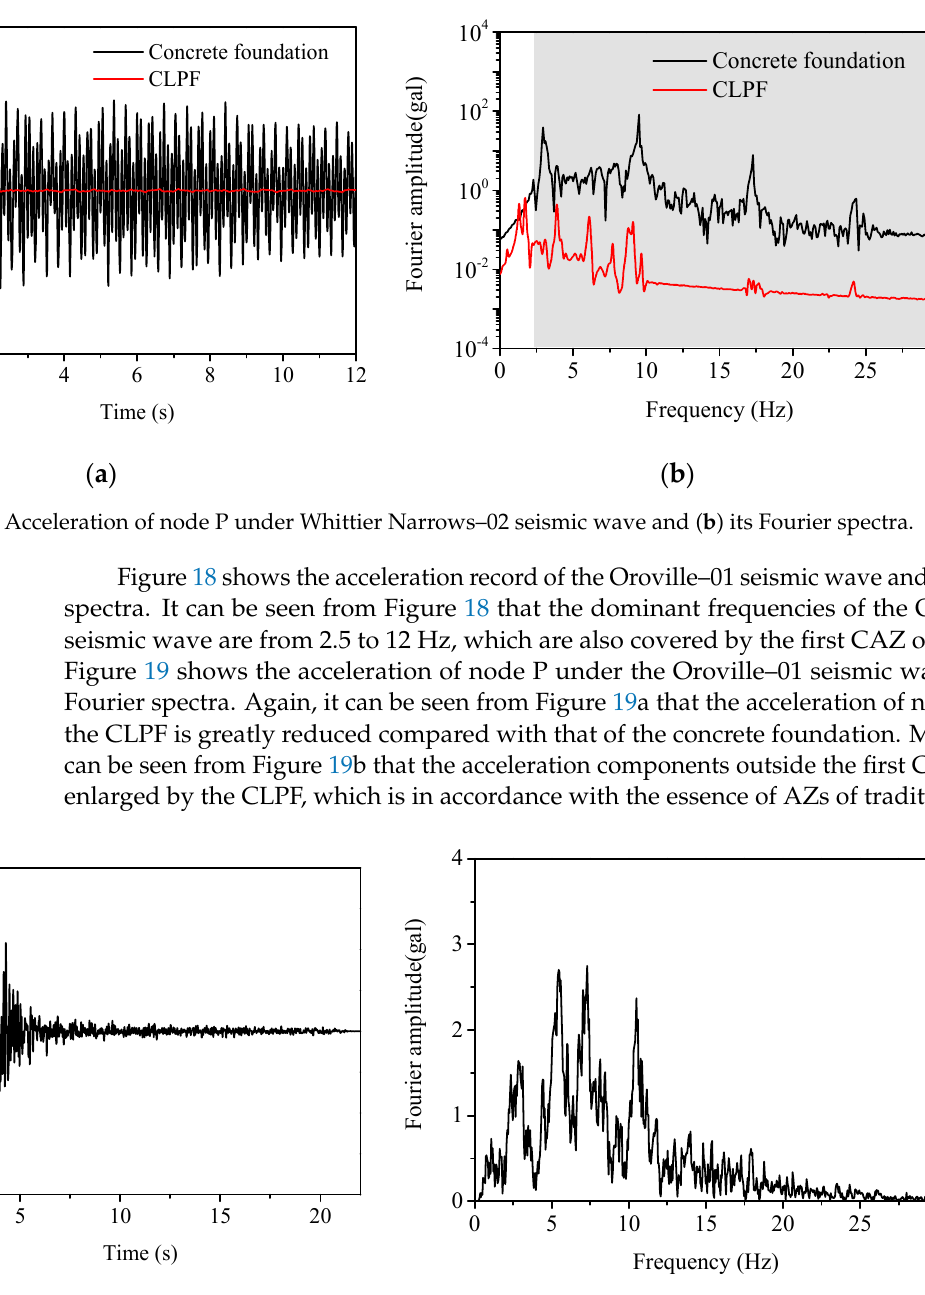
Figure 16. ( a ) Acceleration record of the Whittier Narrows–02 seismic wave and ( b ) its Fourier spectra.